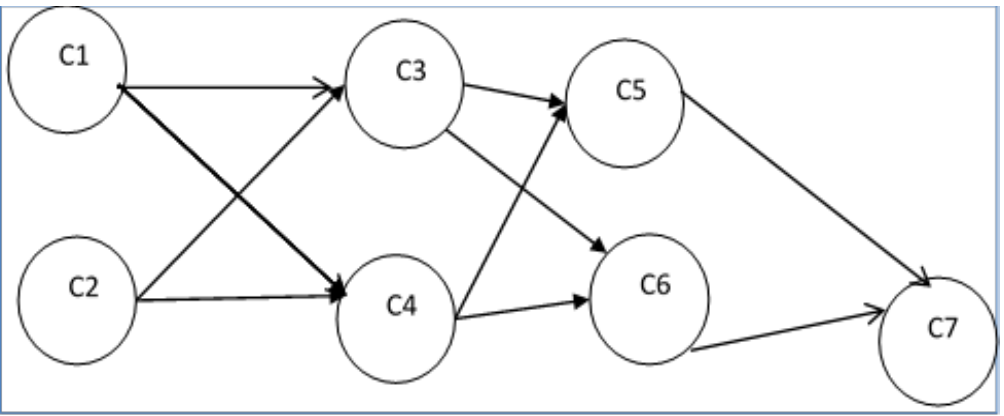
Fig. 1. The Plithogenic cognitive maps.